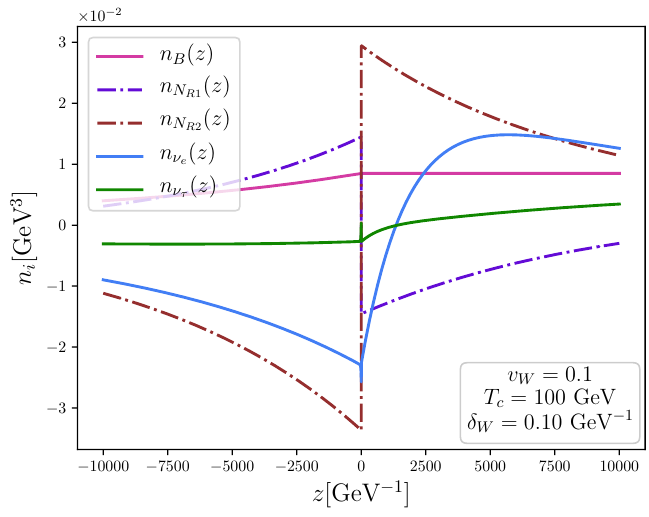
Figure 6 . Evolution of the number densities for baryons and (cid:23) e and (cid:23) (cid:28) from the symmetric phase ( z ) to the broken phase ( z ) in the (cid:13)avoured scenario. The masses of the heavy ! (cid:0)1 ! 1 neutrinos in this particular case are M 1 = 80 GeV, M 2 = 90 GeV and M 3 = 160 GeV while m